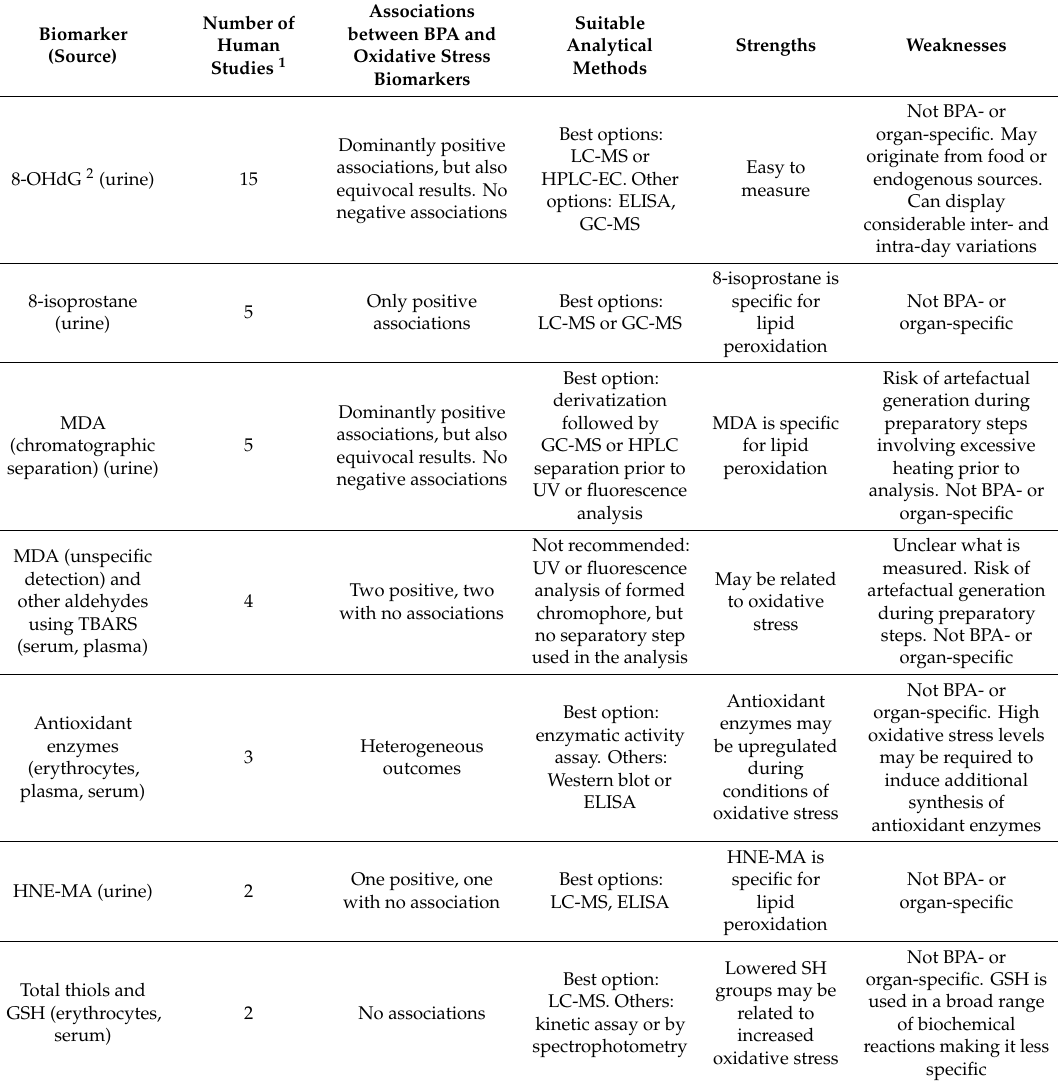
Table 3. Evaluation of analytical methods and strengths and weaknesses of the identified biomarkers of oxidative stress in human studies on